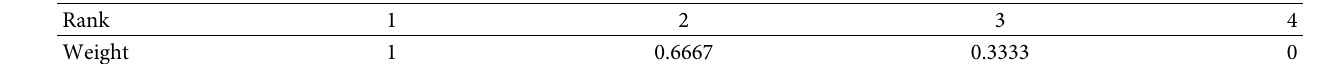
Table 7: The weight distribution.